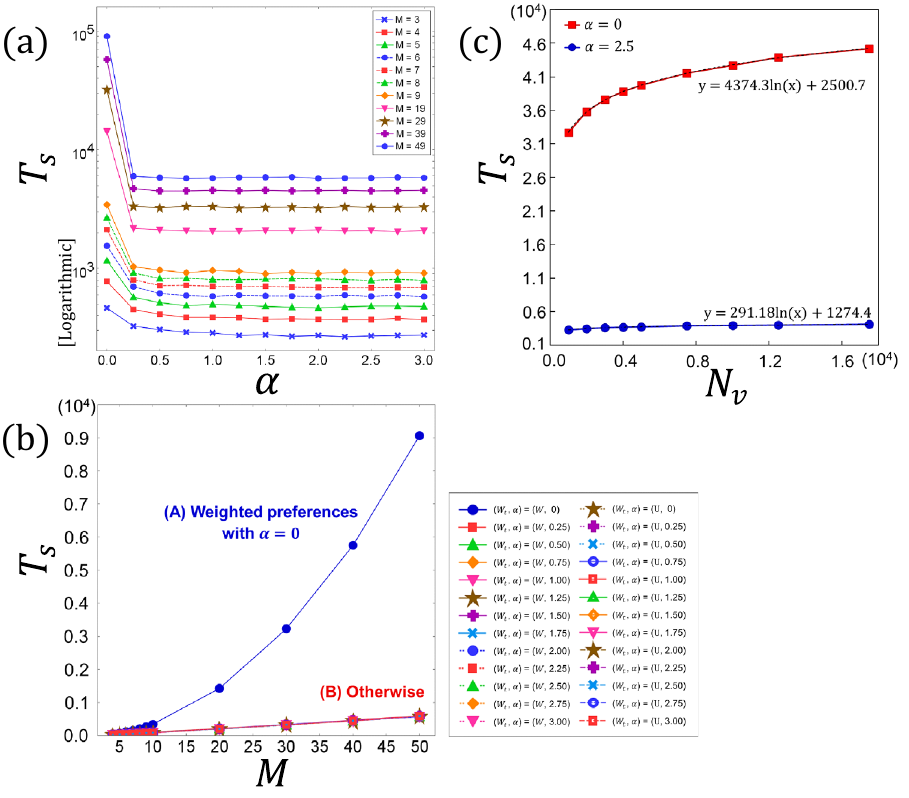
Figure 5. Dependence of travel time steps T s on parameters α , M , and N v in